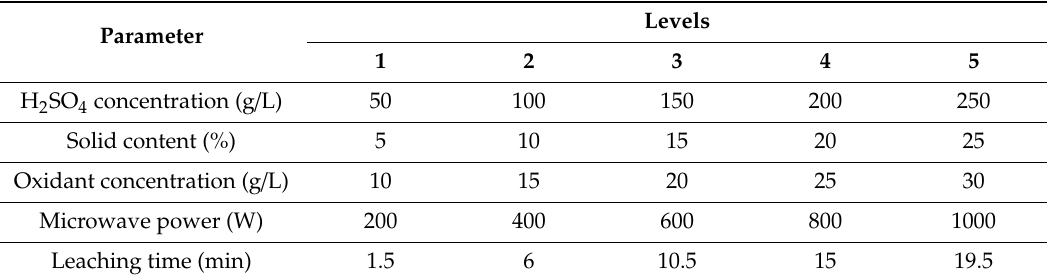
Table 2. The examined parameters and their level.